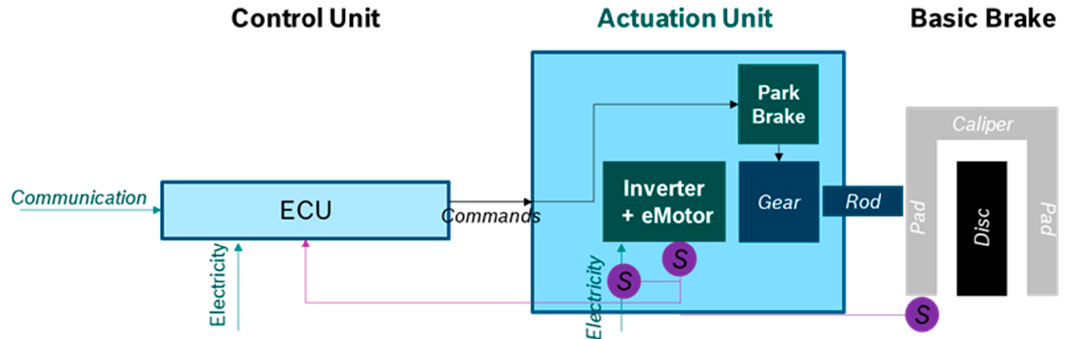
Figure 1 . Scheme of an EMB actuator for a parking brake, based on [25,35]. Figure 1. Scheme of an EMB actuator for a parking brake, based on